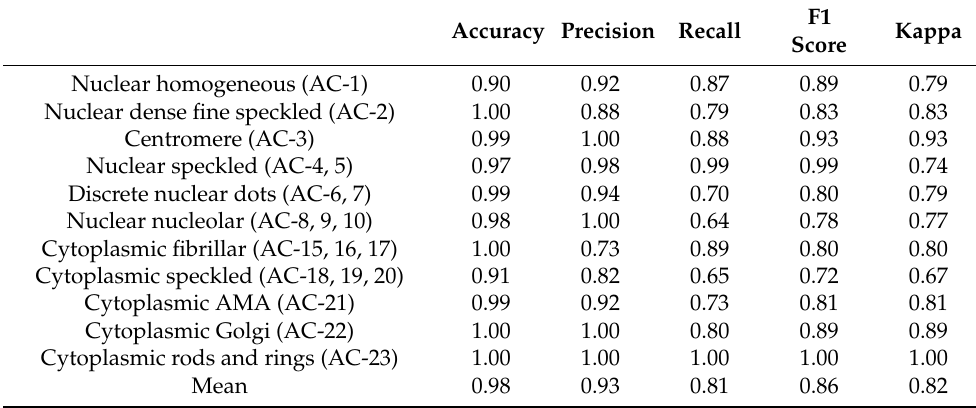
Table 3. Sample prediction performance of the best performance proposed model (InceptionRes- NetV2) on Testing Data 1 a .